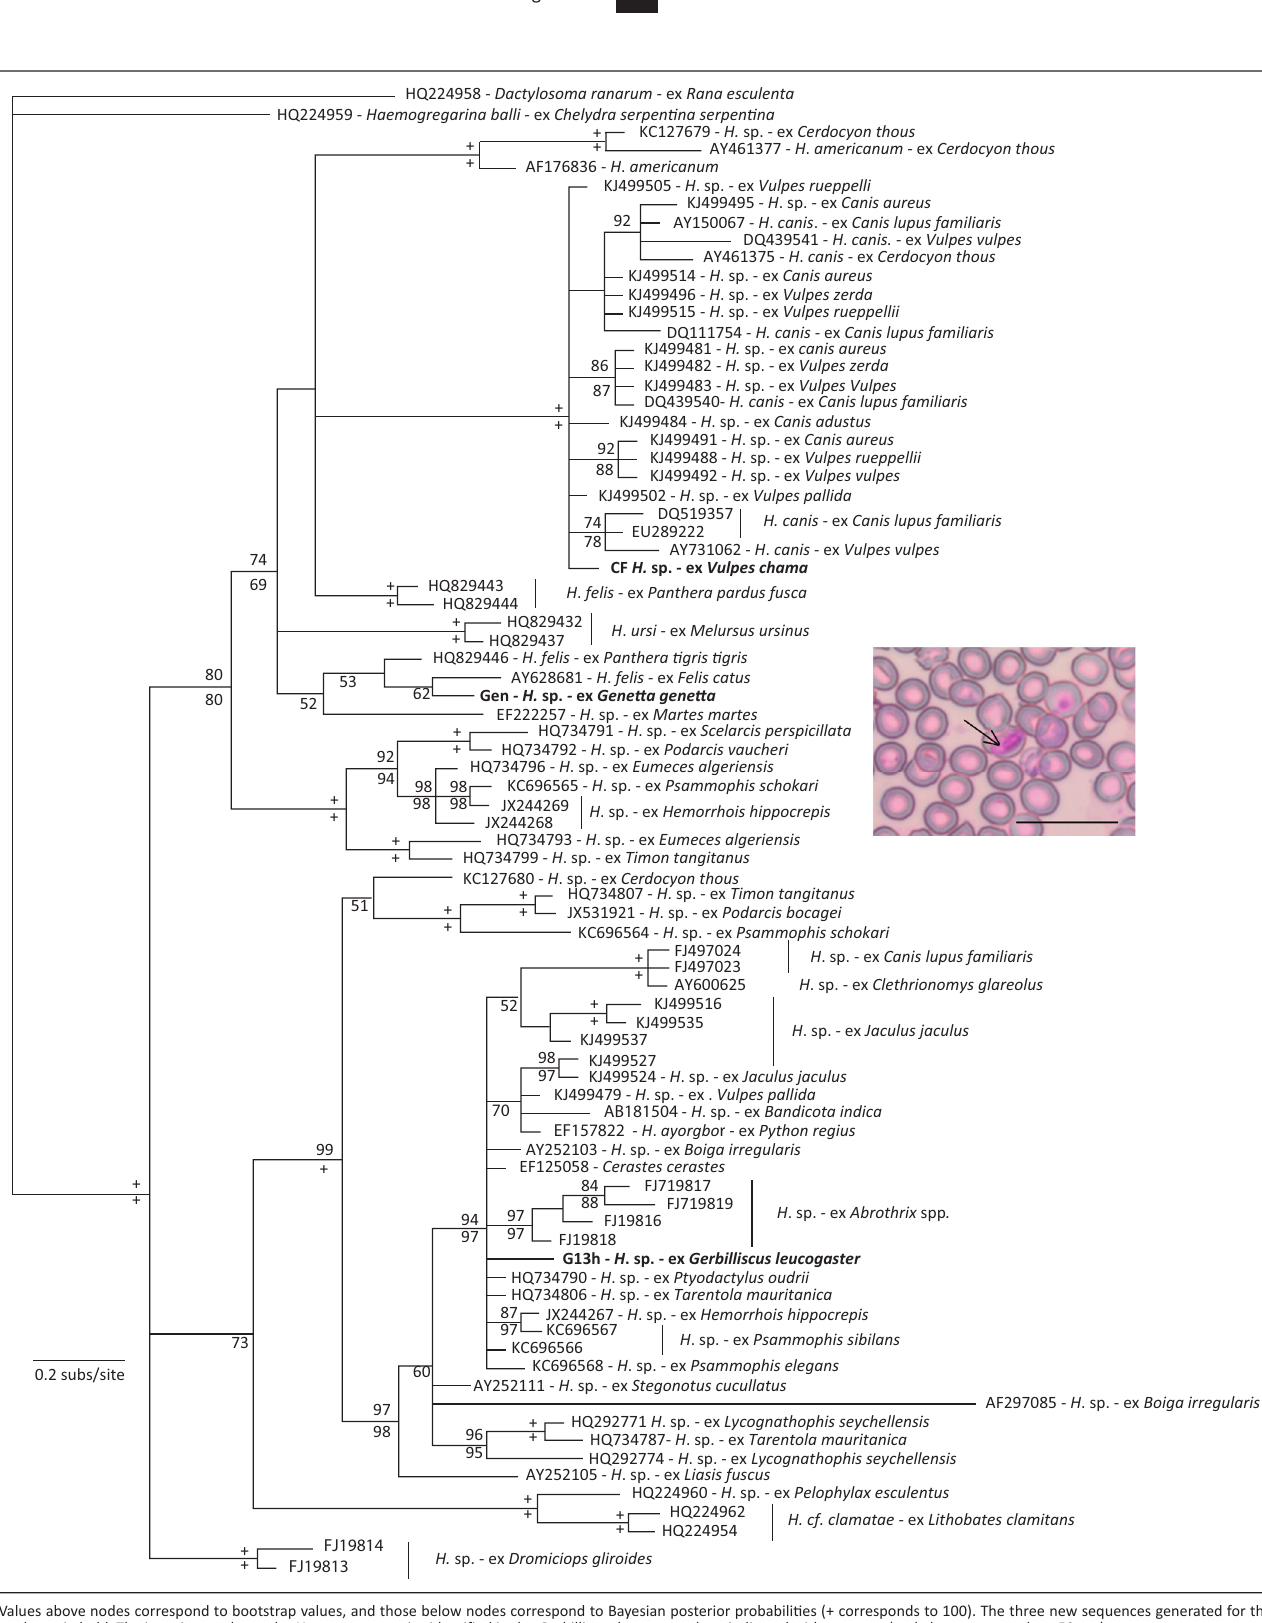
Values above nodes correspond to bootstrap values, and those below nodes correspond to Bayesian posterior probabilities (+ corresponds to 100). The three new sequences generated for this study are in bold. The inset image shows the Hepatozoon species identified in the Gerbilliscus leucogaster host indicated with an arrow (scale bar corresponds to 50 μ m). FIGURE 1: Estimate of relationships of Hepatozoon species derived from partial 18S rRNA using